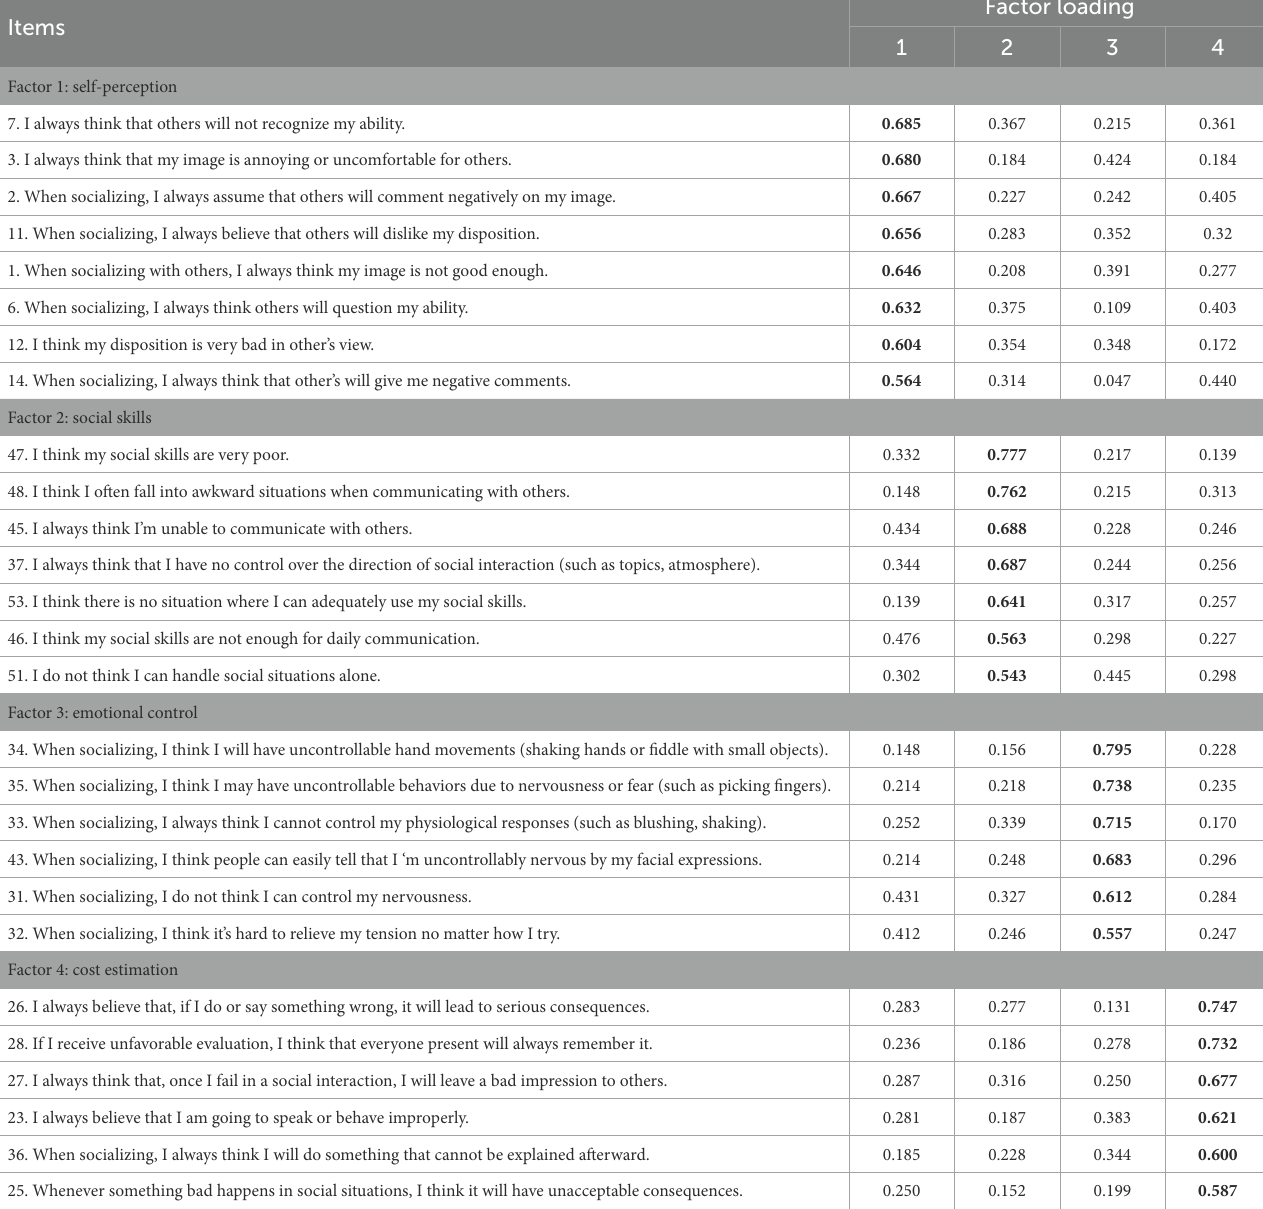
TABLE 2 Exploratory factor analysis of SACS-CS.